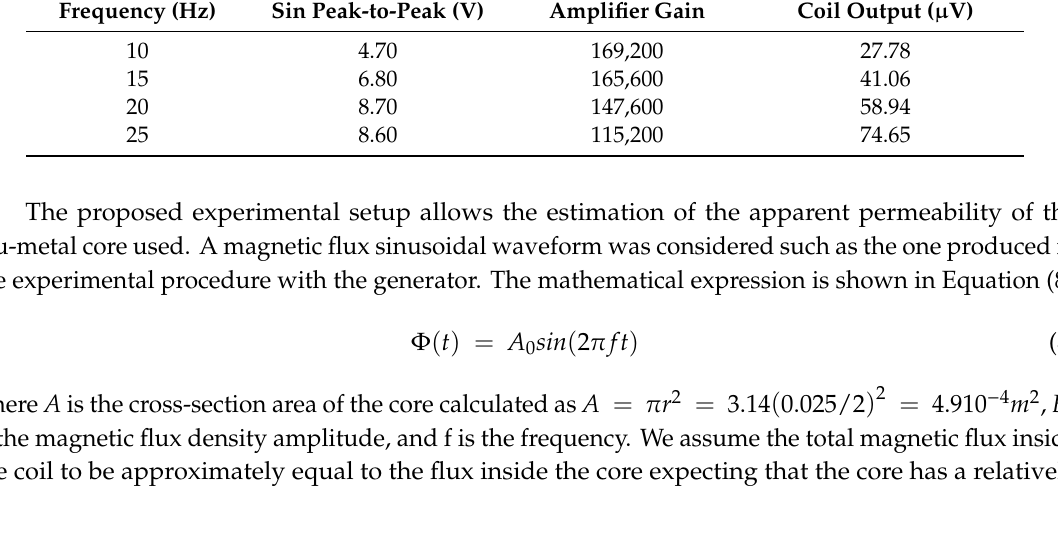
Table 1. Measurement results derived from sinusoidal fitting.